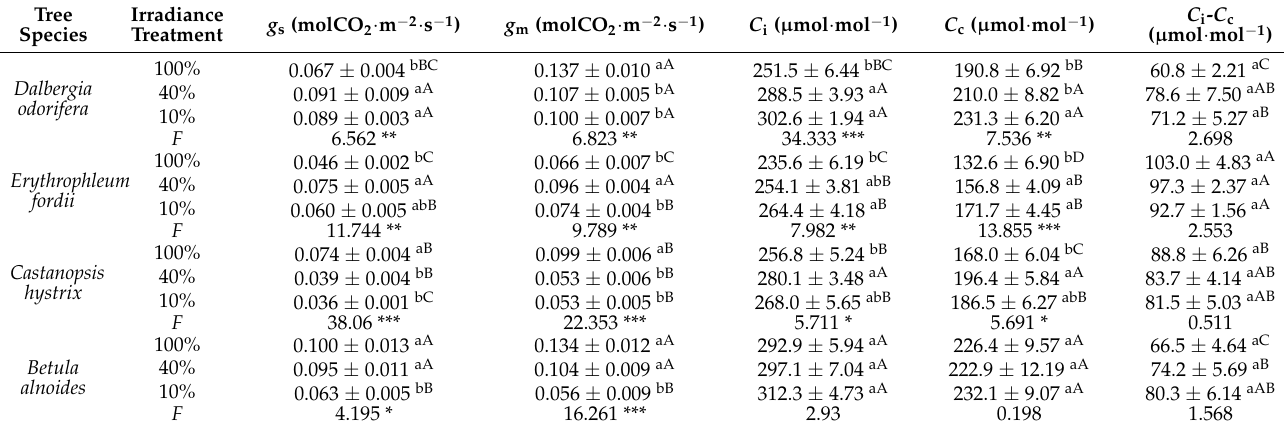
Table 2. Stomatal conductance ( g s ), mesophyll conductance ( g m ), intercellular CO 2 concentration ( C i ), CO 2 concentration at carboxylation site ( C c ) and CO 2 drawdown from the intercellular concentration to the carboxylation site concentration ( C i - C c ) measured in PPFD-saturated conditions in Dalbergia odorifera , Erythrophleum fordii, Betula alnoides , and Castanopsis hystrix grown under three different irradiance treatments. Data are means of seven plants per treatment ± SE. Lower case letters indicate significant difference at 0.05 levels among the irradiance treatments, whereas capital letters indicate significant difference at 0.05 levels among species under same irradiance treatment. F -ratios with statistically significant values denoted by * p < 0.05, ** p < 0.01, *** p < 0.001 among irradiance treatment.